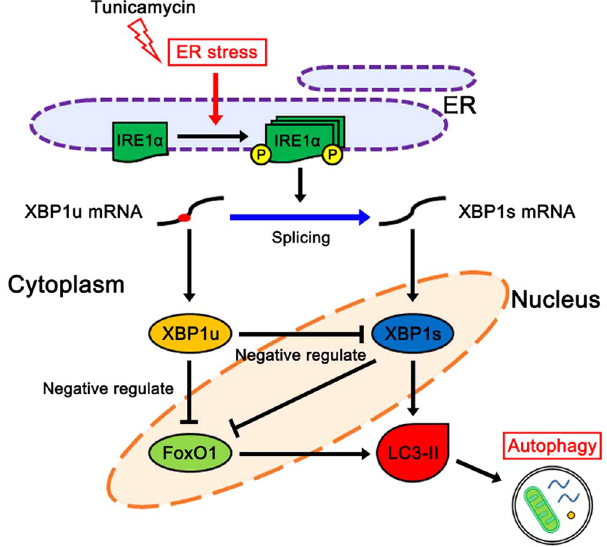
Figure 8. XBP1 regulated autophagy through the interaction of FoxO1 in auditory cells under ER stress condition. A schematic model shows XBP1 splicing induces ER stress-induced autophagy through the transcriptional regulation of FoxO1 in auditory